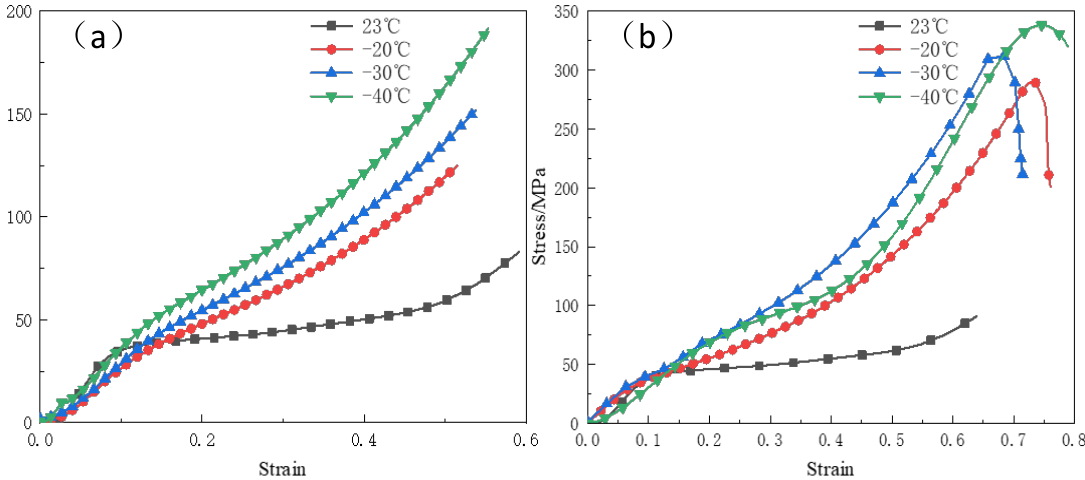
Figure 4. The stress–strain curves of quasi–static compression experiment under the same strain rate at different experimental temperatures ( a ) 0.002 s −1 ;( b ) 0.02 s −1 .